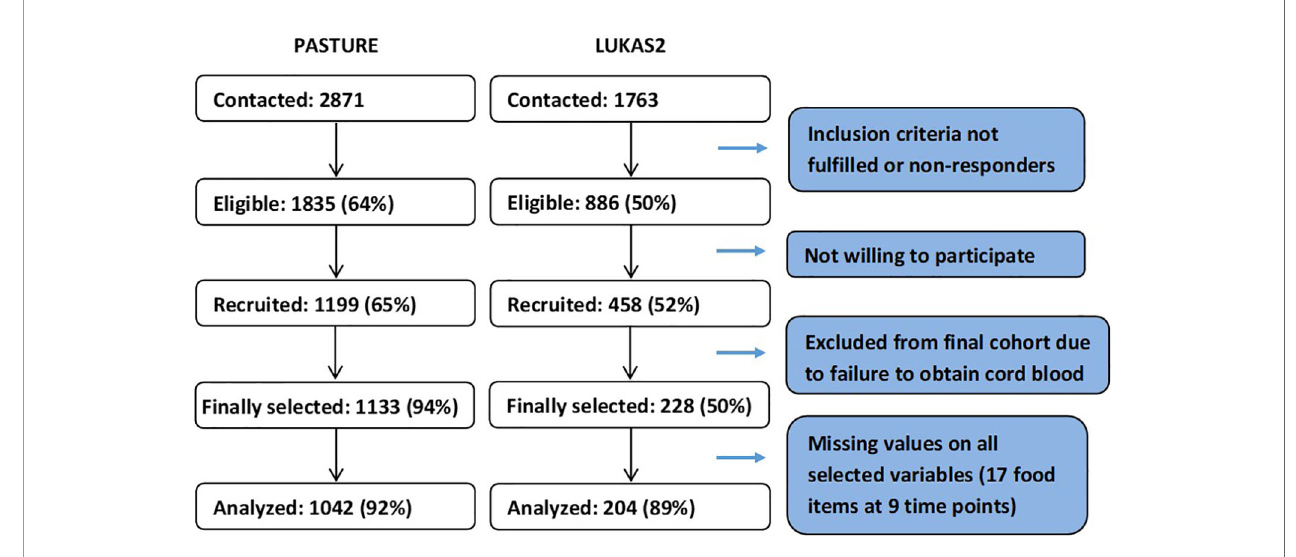
FIGURE 1 | Selection of study populations.